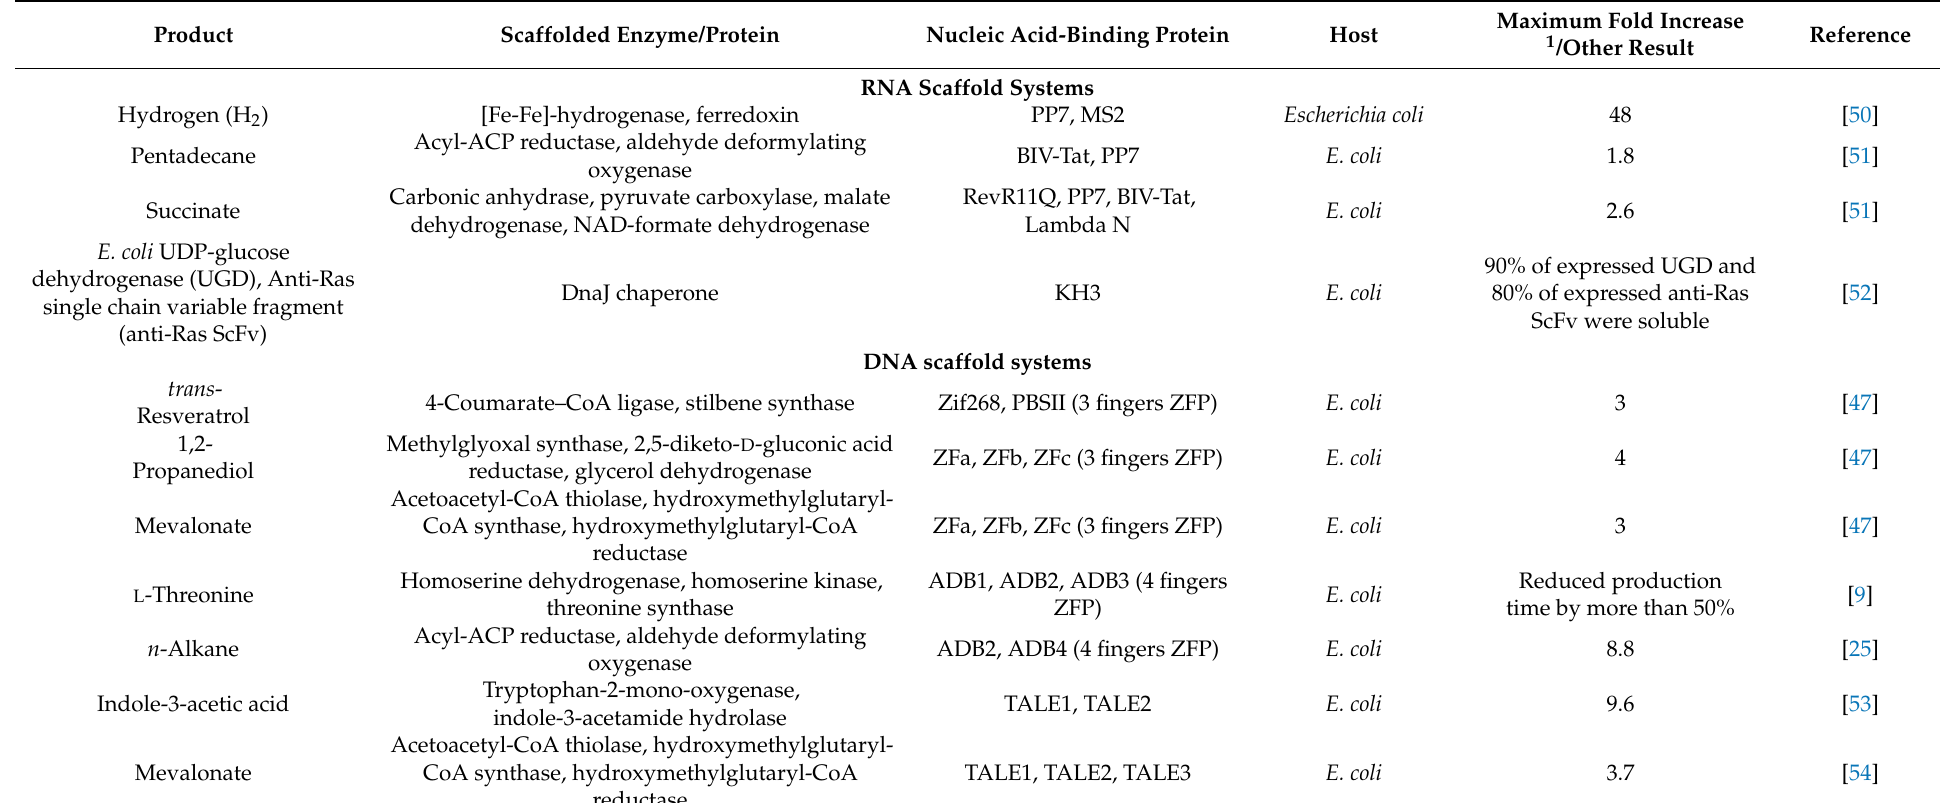
Table 2. Examples of nucleic acid scaffold